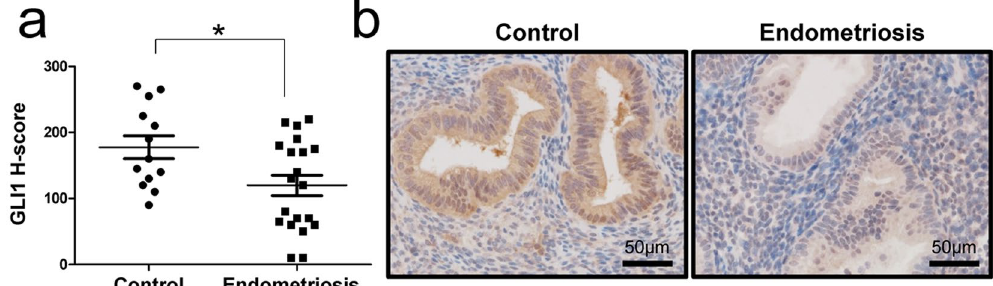
Figure 7. Levels of GLI1 in endometrium from women with and without endometriosis. ( a ) H-score of GLI1 expression in endometrium from women with and without endometriosis. The results represent the mean ± SEM. * p < 0.05. ( b ) Representative photomicrograph of immunohistochemical staining of GLI1 in endometrium from women without and with